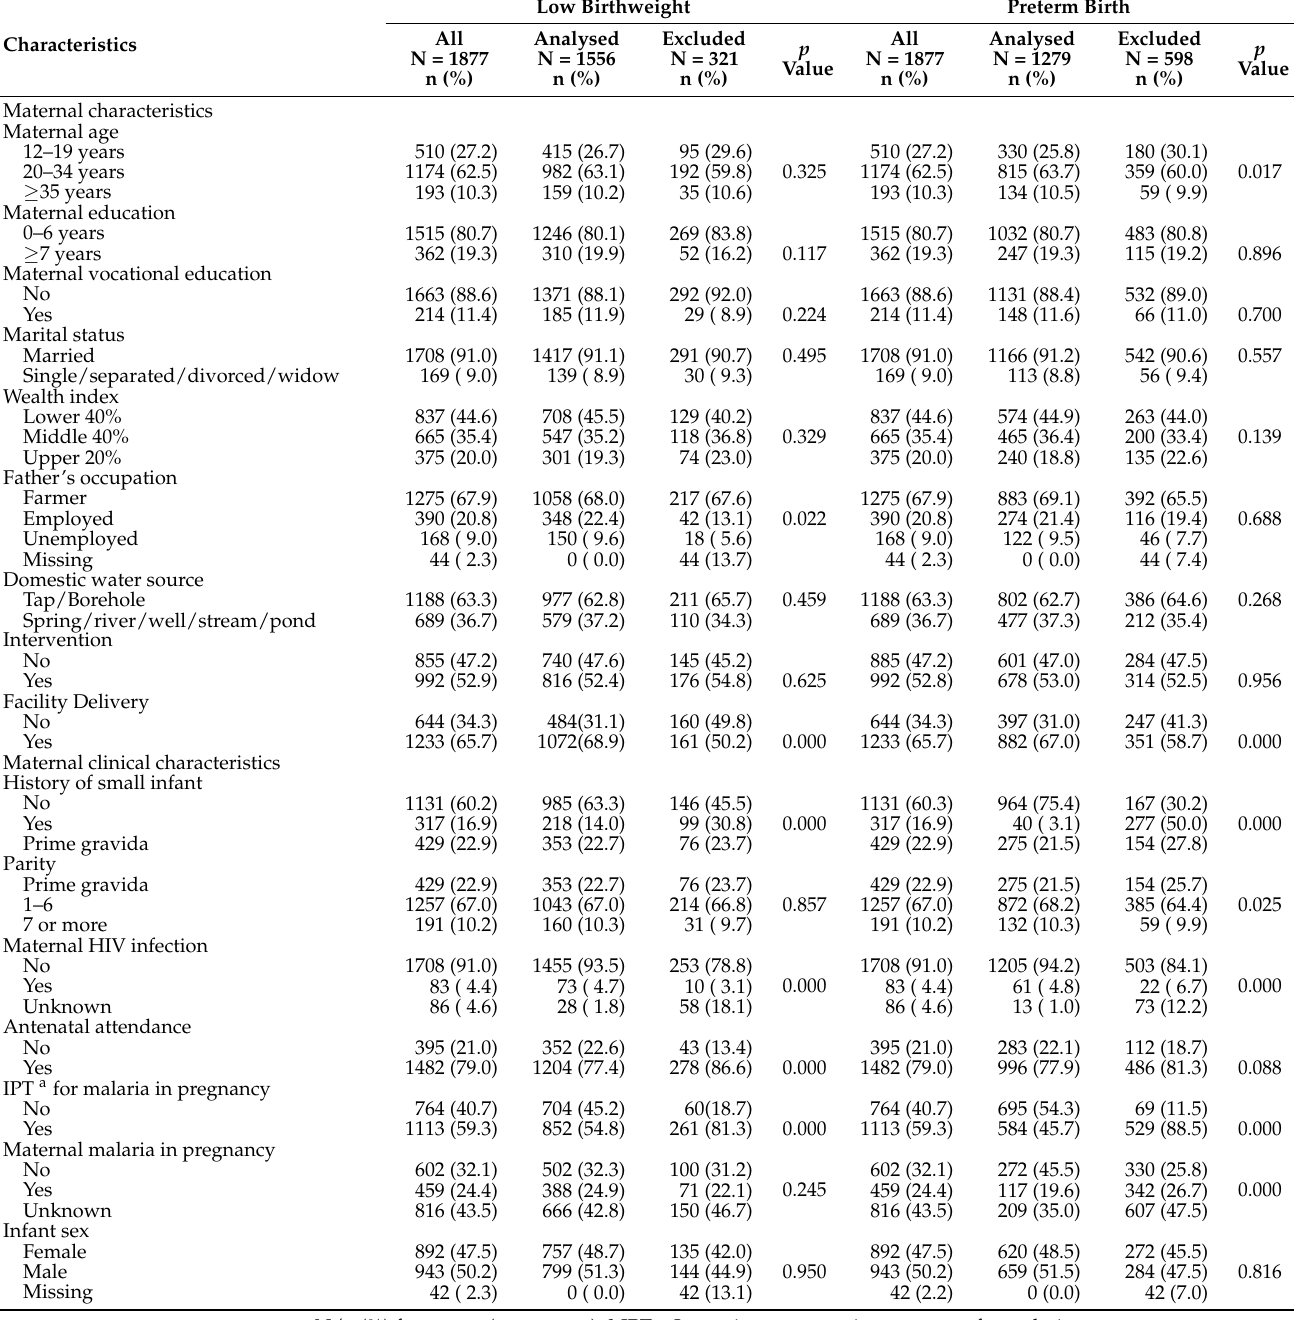
Table 1. Comparison of baseline characteristics between included and excluded study participants in the two analyses—low birthweight and preterm birth—in Northern